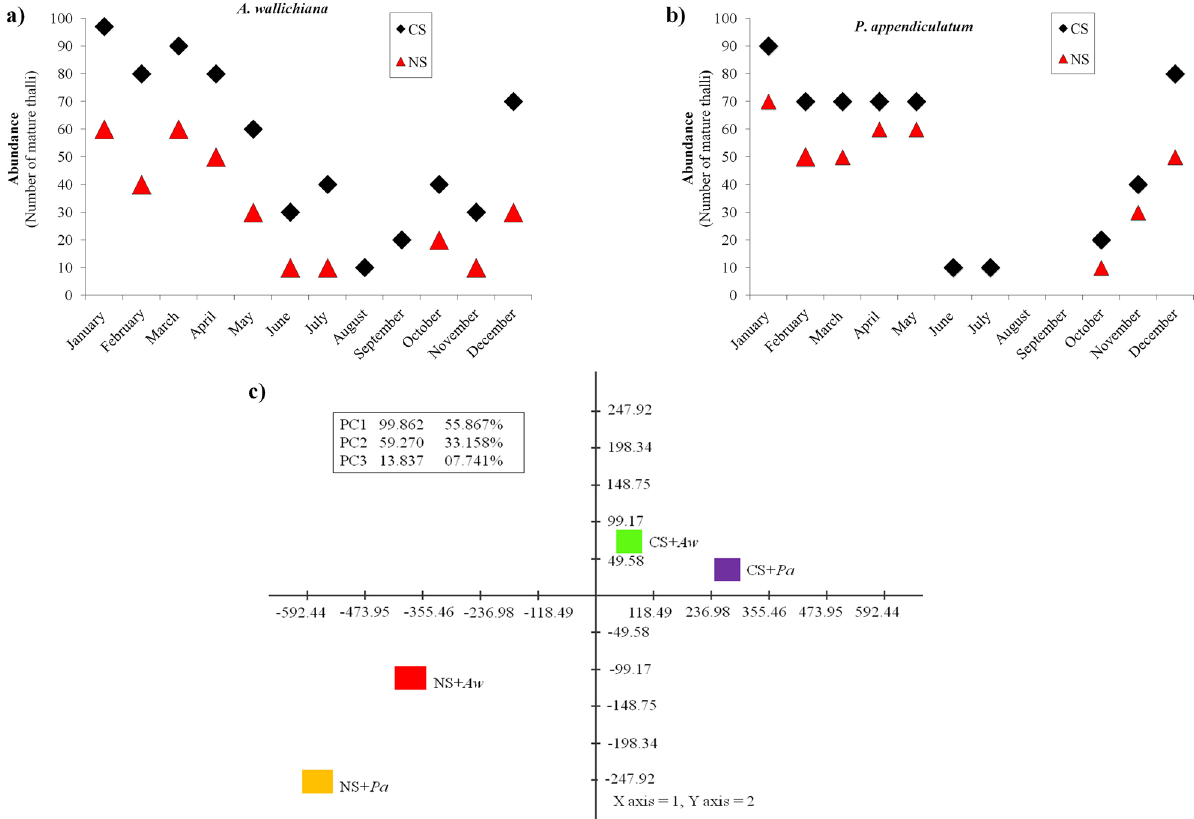
Figure 1. Nickel excess affects abundance of liverworts. (a,b) showing impacts of nickel (Ni) excess on the abundance of (a) Asterella wallichiana and (b) Plagiochasma appendiculatum in Ni-excess sites (NS, n = 5) compared with control sites (CS, n = 5) during January 2017 to December, 2017 in natural habitats under field conditions in quadrates ( n = 10; 10 × 10 cm 2 /quadrat) laid on each of NS and CS, (c) principal component analysis showed impacts of Ni excess on variation in abundance of A . wallichiana and P . appendiculatum in natural habitats under field conditions in quadrates ( n = 10; 10 × 10 cm 2 /quadrat) laid on each of NS ( n = 5) and CS ( n = 5) . CS + Aw and CS + Pa denote control sites + A . wallichiana and P . appendiculatum , whereas NS + Aw and NS + Pa denote Ni excess sites + A . wallichiana and P . appendiculatum, Effect of Ni excess on the phenological events of liverworts. Both A . wallichiana and P . appendicu‑ latum were collected from CS and NS sites in their young gametophytic stages lacked mature antheridia and archegonia. These young gametophytic samples of male and female thalli of A . wallichiana and P . appendicula‑ tum were examined for the development of mature antheridia and archegonia, and post-fertilization changes to develop sporophyte, with four visits spreading over the one year period. Effect of Ni excess on abundances of liverworts. The abundances of A . wallichiana and P . appendiculatum were counted in terms of the number of mature gametophytic thalli in both NS and CS sites. The impact of Ni excess on the abundances of A . wallichiana and P . appendiculatum was examined during a one-year period (January 2017-December 2017) (Fig. 1a,b) . In general, A . wallichiana showed more abundance than P . appendiculatum throughout the year in CS. However, in NS, A . wallichiana exhibited a higher reduction in abundance as com- pared to P . appendiculatum . The maximum reduction in abundance was observed in December, January, and February month in A . wallichiana by the difference in the average number mature thalli by 40, 40 and 40, respec- tively than in P . appendiculatum by 20, 20 and 30, respectively (Fig. 1a,b). Furthermore, principal component analysis (PCA) also indicated that the variation in the abundances of mature gametophytic thalli was more evident in P . appendiculatum than in A . wallichiana grown in Ni excess sites in NS (Fig. 1c). Population viability analysis (PVA) carried out on the young gametophytic thalli of A . wallichiana and P . appendiculatum grown on the CS and NS showed visible differences in the distribution of reproductively active archegonia and antheridia. Transition of the young gametophytic thalli into archegonia and antheridia produc- tion was counted during a period of four weeks. During this time, NS showed significant impact on lowering the number (N) of reproductively active archegonia and antheridia in both the liverworts compared to CS (Fig. 2a,b). However, A . wallichiana exhibited a higher reduction in the number of reproductively active archegonia and antheridia compared to P . appendiculatum (Fig. 2a,b). Furthermore, the quasi-extinction (QE) (i.e., the prob- ability calculated versus threshold level) also showed a negative effect of Ni excess on the distribution patterns